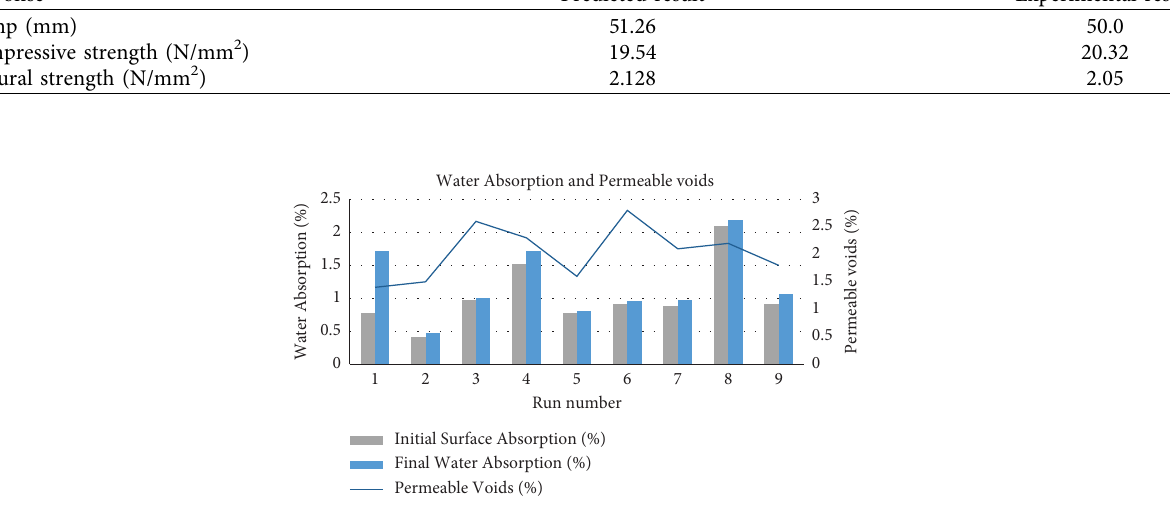
Figure 14: Efects of RHA and PETp on the permeable void and water absorption properties of